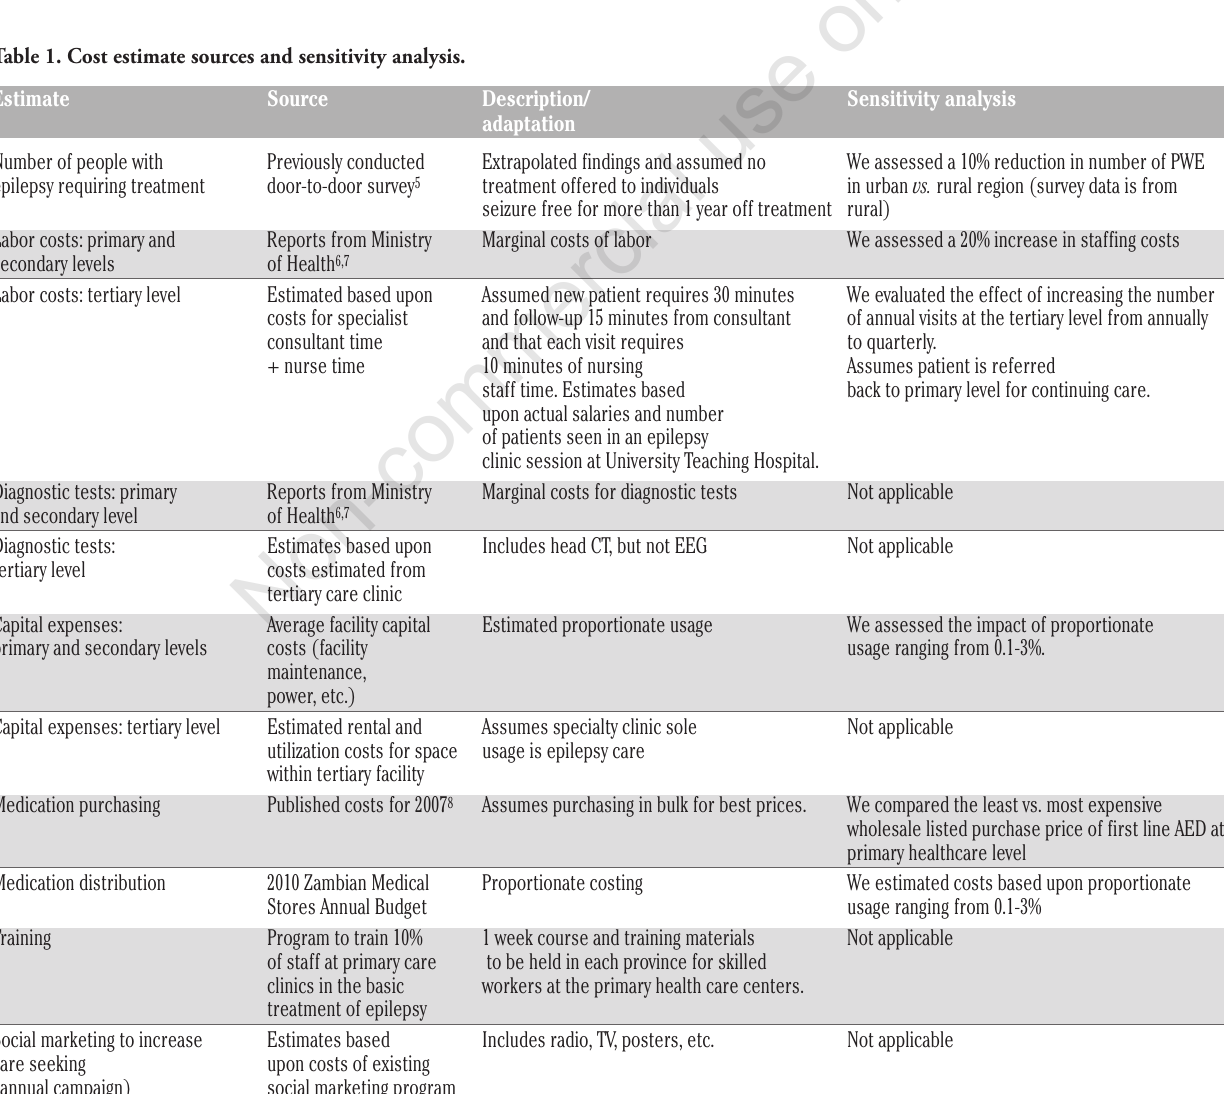
Table 1. Cost estimate sources and sensitivity analysis. Estimate